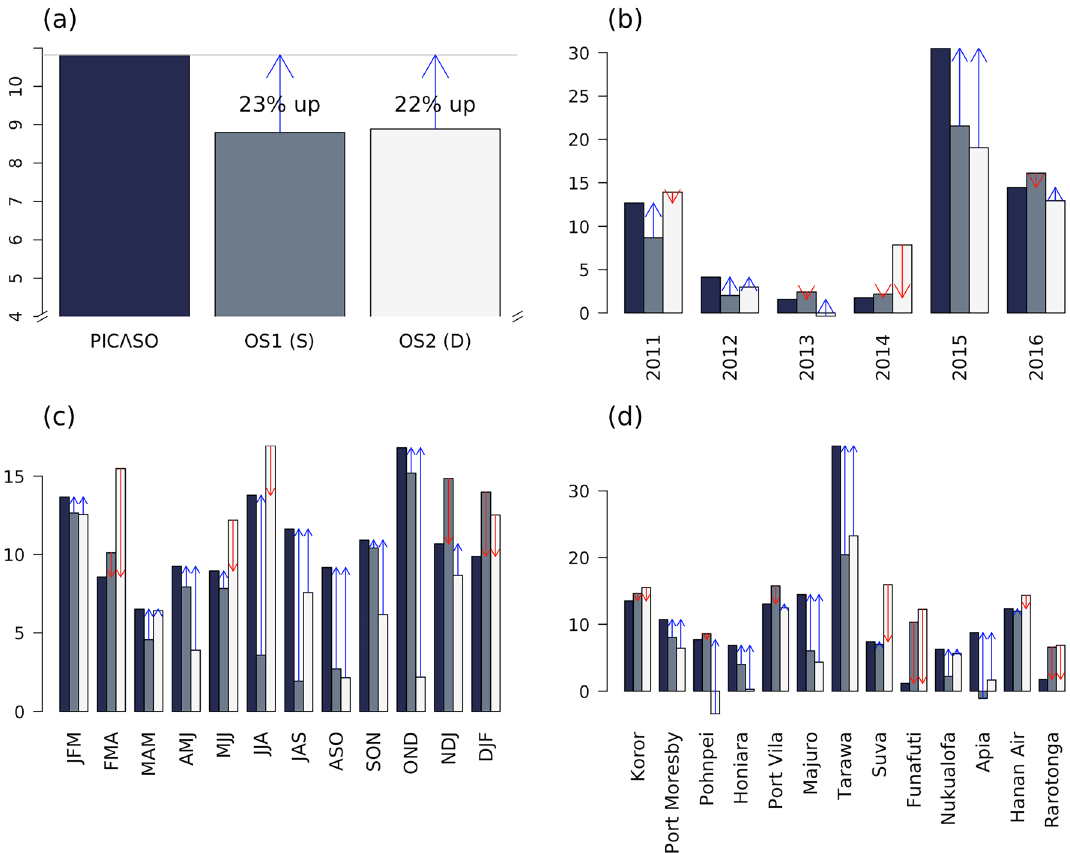
Figure 4. ( a ) LEPS scores of PICASO and two existing operational systems, OS1 (statistical model) and OS2 (dynamic model) in the Pacific derived from the stations located in the capital of 13 PICs for 12 seasons during six validation years (2011–2016) and their variation with the individual ( b ) 6 years, ( c ) 12 seasons, and ( d ) 13 stations. Blue (red) arrows indicate the score increment (decrement) of PICASO from each of the other two